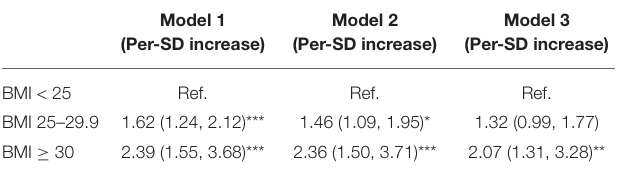
TABLE 5 | Association of LH/FSH ratio with obesity categorized by BMI: logistic regression.